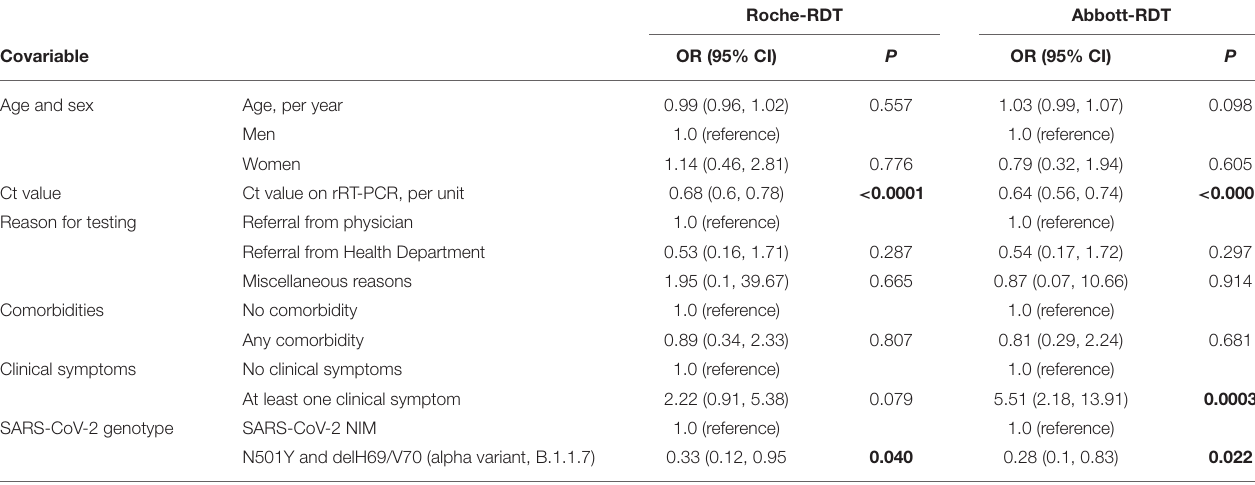
TABLE 3 | Predictors of positive RDTs amongst SARS-CoV-2-rRT-PCR-positive samples in multivariate logistic regression models * .